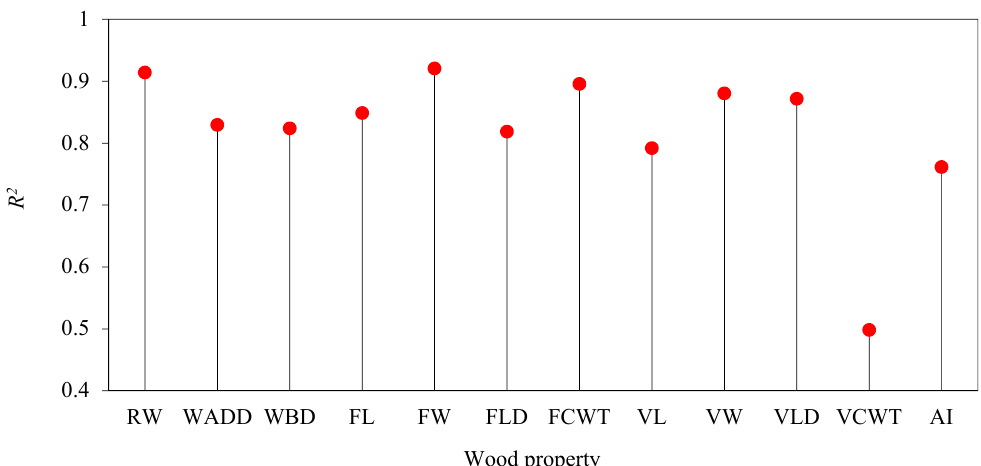
Figure 10. Demarcation of juvenile wood, transition wood and mature wood in S. superba . RW: ring width, WADD: wood air-dry density, WBD: wood basic density, FL: fiber length, FW: fiber width, FLD: fiber lumen diameter, FCWT: fiber cell wall thickness, VL: vessel length, VW: vessel width, VLD: vessel lumen diameter, VCWT: vessel cell wall thickness, AI: aggregative indicator.